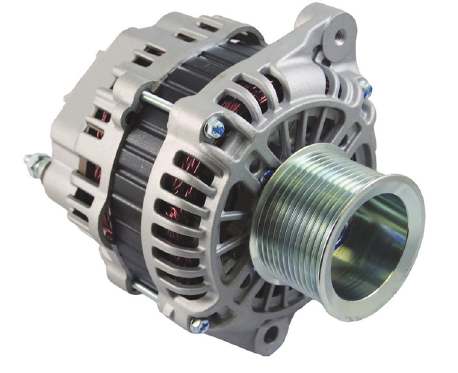
Fig. 3. General view of a generator used the project [24] The generator's rated voltage is 28 V, while the nominal charging current is equal to 90 A and can be obtained start- ing from a rotational speed of 6000 rpm. The generator is excited electromagnetically by a rotor with 6 pole